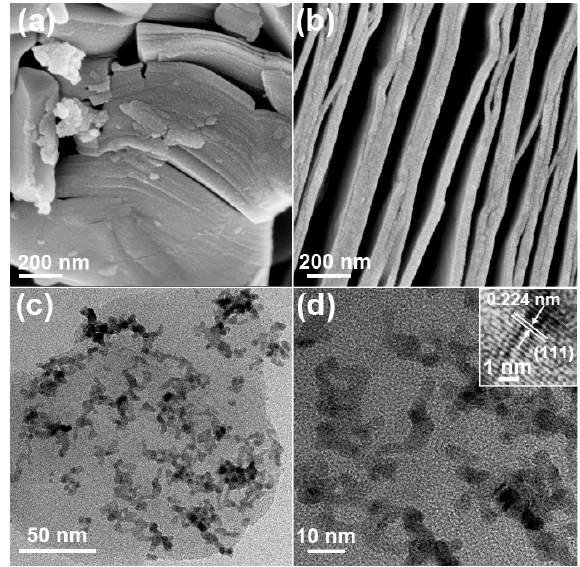
Figure 2. ( a ) SEM image of Ti 3 AlC 2 . ( b ) SEM image of Ti 3 C 2 X 2 . ( c , d ) TEM images of Pd/alk-Ti 3 C 2 X 2 at different magnifications (the inset is the HRTEM image of Pd nanoparticles).